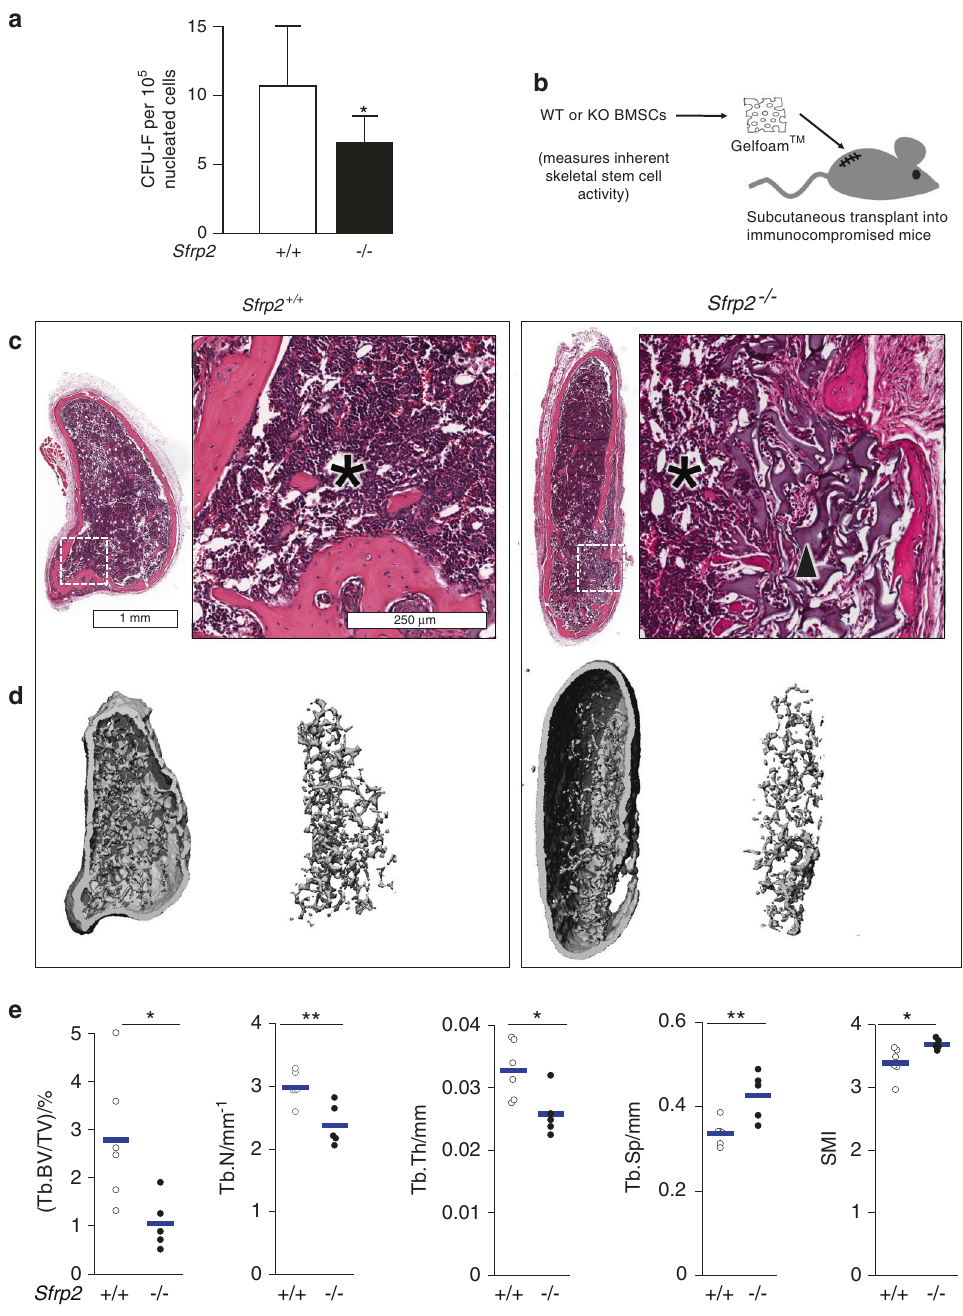
Fig. 3 Sfrp2 -de fi cient BMSCs/SSCs have lower colony-forming ef fi ciency and reduced osteogenic differentiation in ectopic bone transplants. a Colony-forming ef fi ciency assay showing colony-forming units- fi broblasts (CFU-F) per 100 000 nucleated bone marrow cells from WT and Sfrp2 KO littermates. b Gelatin sponges were loaded with 2 × 10 6 BMSCs/SSCs depleted of hematopoietic cells and transplanted into subcutaneous pockets in immunocompromised mice for 8 weeks. c H&E-stained sections of the transplants. WT BMSCs/SSCs formed a complete bone/marrow organ, with cortical and trabecular bone, stroma that supports hematopoiesis of mouse origin (black asterisk). Sfrp2 KO BMSCs/SSCs were less osteogenic; transplants showed residual gelatin sponge scaffold material (black arrowheads, far right panel). d µCT reconstructions of transplants and their trabecular compartments. e µCT analysis of trabecular bone. Compared with WT transplants, Sfrp2 KO transplants had fewer, thinner trabeculae that were more separated and had abnormal geometry (SMI). (Tb.BV/TV)/% Trabecular bone volume/Total volume (%), Tb.Th Trabecular Thickness, Tb.Sp Trabecular Separation, Tb.N Trabecular Number, SMI Structure Model Index. Individual values are shown as fi ve white ( WT ) or six black circles ( Sfrp2 KO), and blue bars represent the mean. * P < 0.05; ** P < essential for fetal or postnatal modeling and remodeling of the we thoroughly studied their skeleton using X-Rays, DEXA (not skeleton in mice. Interestingly, Sfrp1 KO mice are also born shown), µCT and histology. Our analyses failed to reveal normal, but Sfrp1 and Sfrp2 double de fi ciency causes lethality, differences between either young (2 – 3-month-old) or old (11- shortening of the thoracic region and abnormal limb morpho- month-old) sex-matched Sfrp2 KO and WT littermates (Fig. 2, genesis. 39 This indicates a high degree of redundancy in the Supplementary Figs. 1, 2), demonstrating that Sfrp2 is not